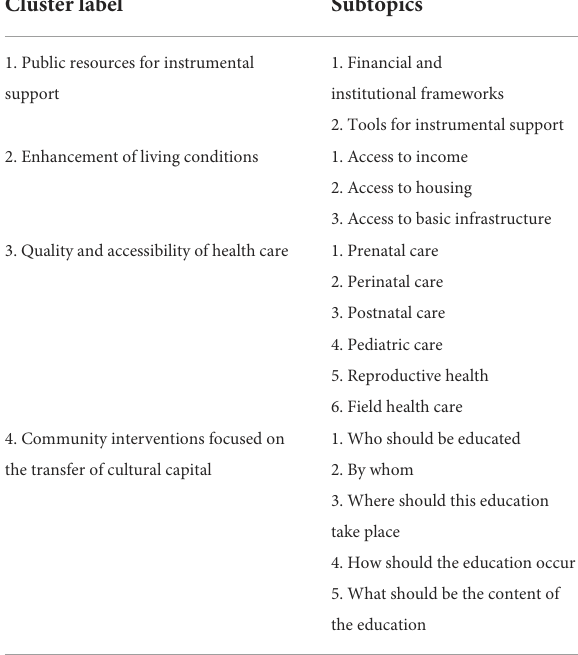
TABLE 2 Clusters of measures and interventions targeting early childhood health and development in MRCs in Slovakia according to professionals working with the target